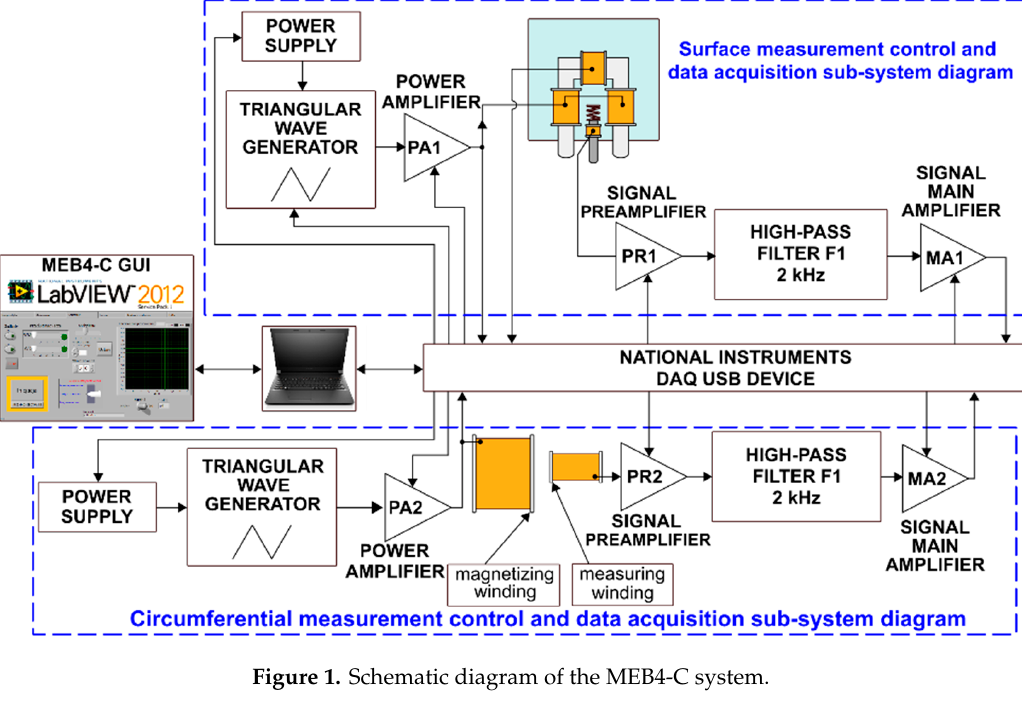
Figure 1. Schematic diagram of the MEB4-C system.